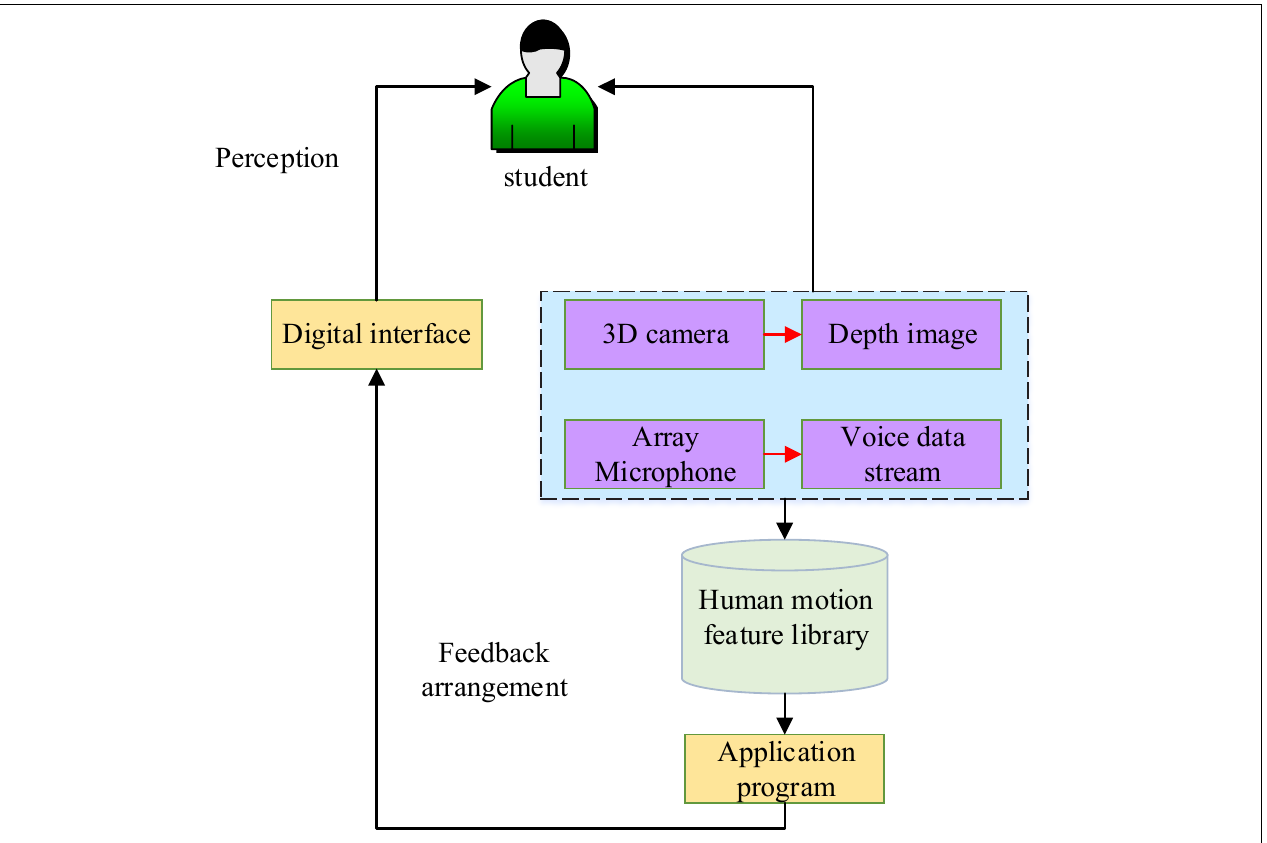
FIGURE 1 | Motion sensing technology based on human-computer interaction in Physical Education